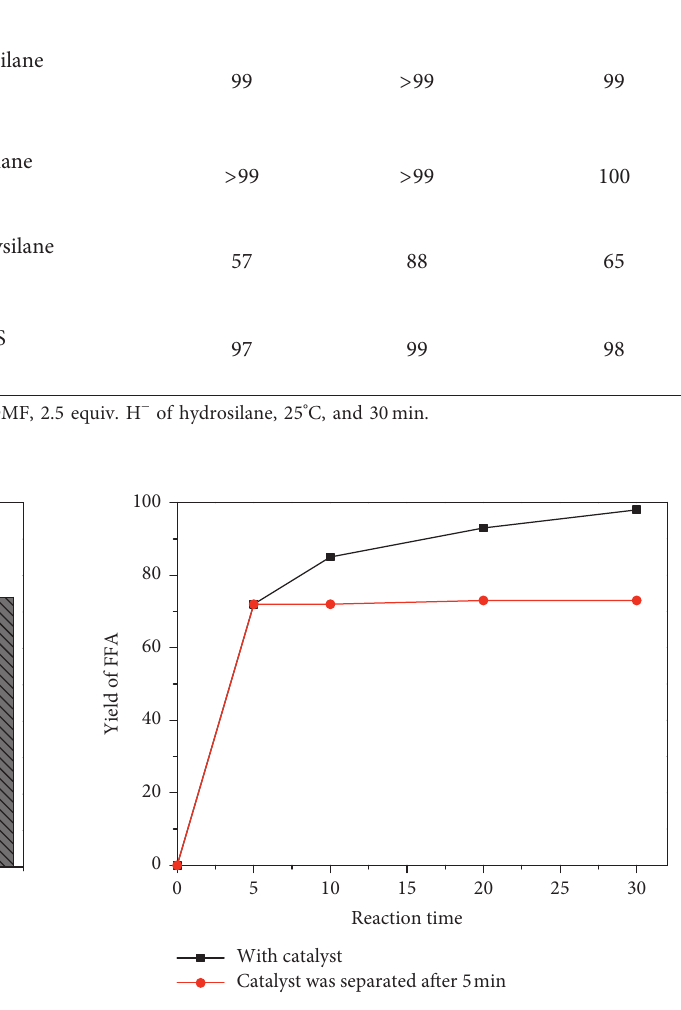
Figure 8: Catalyst recycling study of 5wt.% KF/ZrO conditions: 0.5 mmol FUR, 25mg 5 wt.% KF/ZrO 2 , 2mL DMF, 2.5 equiv. H − of PMHS, 25 ° C, and 30min.